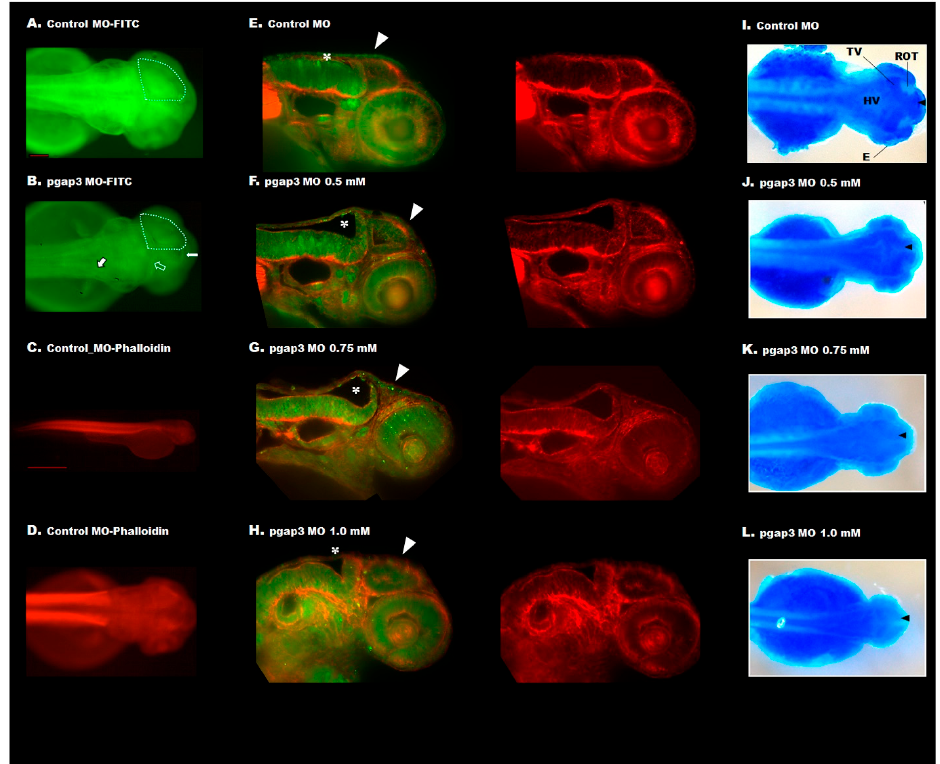
Figure 5. Knockdown of Pgap3 resulted in zebrafish in dose-dependent midbrain tectum and cerebellum defects. ( A ) Zebrafish injected with control MO-FITC displayed normal brain development, normal midbrain with expanded left and right tectal ventricles at 72 h post-fertilization (hpf). ( B ) Zebrafish injected with pgap3 MO-FITC showed failure for developing tectum that connects the left and right ventricles of the midbrain (traced by dotted white shape) demonstrated by clear separation (white arrow), impaired midbrain-hindbrain boundary (empty white arrow), and brain stem malformation (black-white arrow). ( C , D ) Whole-mount immunofluorescence zebrafish using phalloidin to stain actin filaments (red). Zebrafish imaging using Zeiss Lumar 12 stereomicroscope, full-body at 32 × , scale bar 100 µ m, and dorsal view at 100 × magnification, scale bar 10 µ m. ( E – H ) Examination of the zebrafish midbrain using light-sheet imaging for two channels of red (actin) and green (MO-FITC), images of red channel (phalloidin stain of actin) is included. ( E ) Control zebrafish had normal brain development, normal midbrain with connected. They expanded left and right tectal ventricles, white arrowhead showing the tectum, and white asterisk showing the position of the cerebellum. ( F – H ) The knockdown of Pgap3 resulted in developmental brain deformities. Examined zebrafish pgap3 morphants showed brain defects and widely separated ventricles. Imaging using light-sheet microscopy at magnification 16 × . ( I – L ) Separation of the tectal zebrafish left and right ventricles demonstrated by Luxol blue-cresyl violet staining. Anatomy of the zebrafish brain: E, eye; midbrain parts: OT, optic tectum (R, right); TV, tectal ventricle and HV, hindbrain ventricle. Zebrafish imaging using Zeiss Lumar 12 stereomicroscope with a ZEISS camera (Model Axiocam Erc 5s) at a magnification of 32 ×